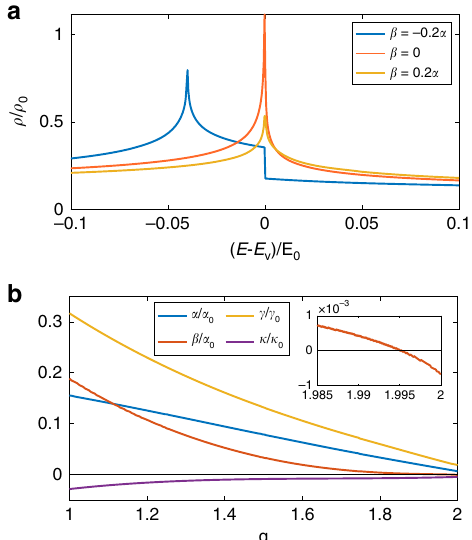
Fig. 3 Density of states (DOS) and coef fi cients of Taylor expansion around saddle point during the topological transition of VHS. a DOS of Eq. (5) with different β , where E 0 ¼ α 3 = ~ γ 2 ; ρ coef fi cients of Eq. (3) as functions of g when g 0 ¼ 1 : 2 g . Here α 0 ¼ λ v ; γ λ 2 v and κ ¼ λ 3 v . Inset of b is zoom-in plot where β changes sign near 0 high-order VHS while α ; γ ; κ do